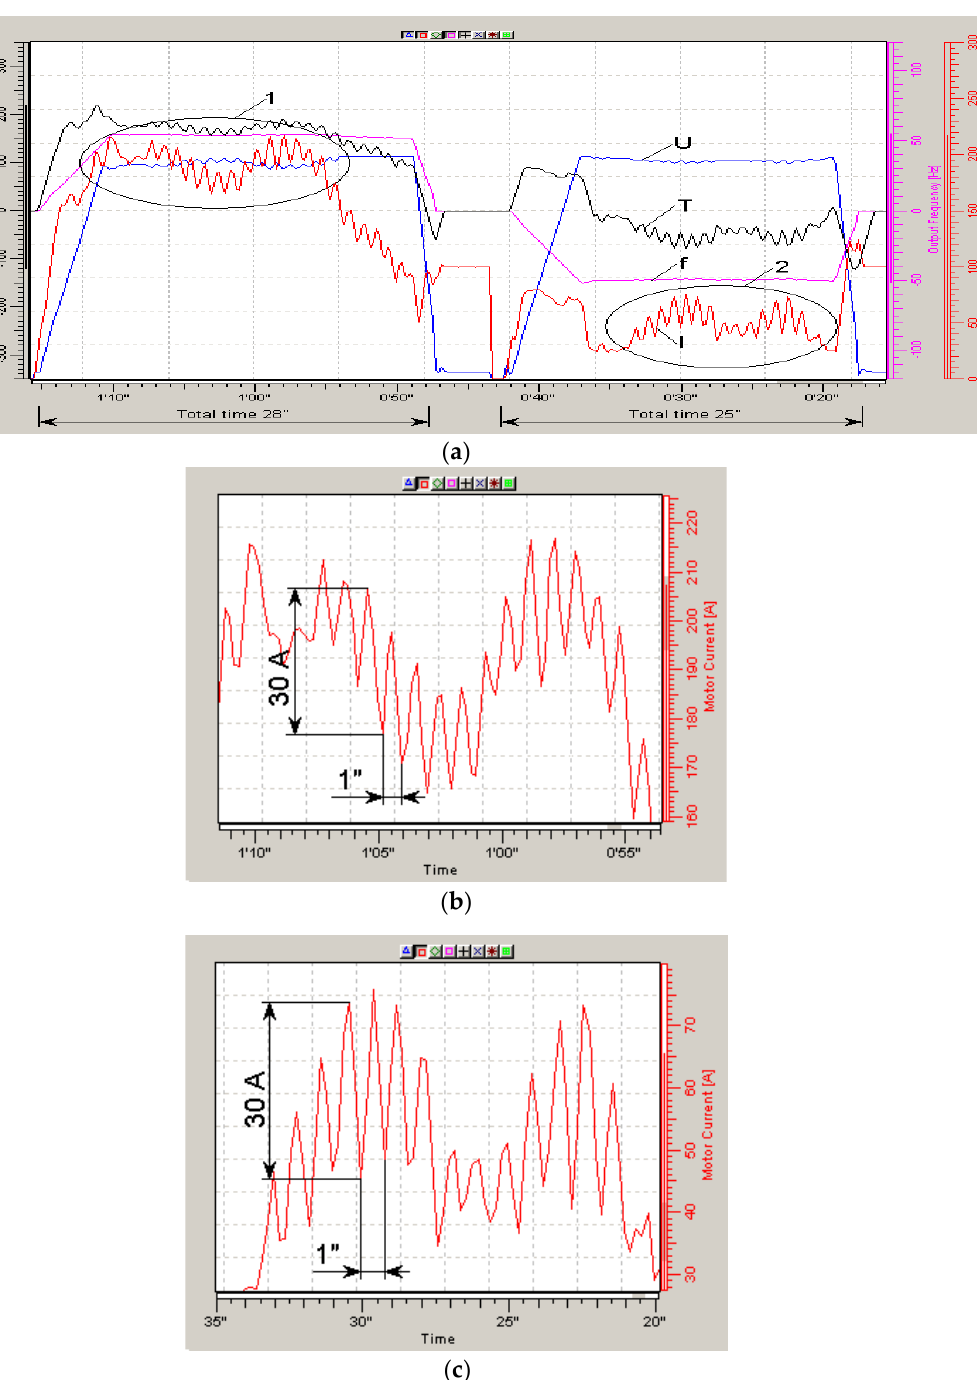
Figure 16. Diagrams of movement at high speed along track 4 with parameters U = 660 V, f = 50 Hz and U/f = 13.2 Fl ( a ) and extended sections 1 ( b ) and 2 ( c ) of the current diagrams.